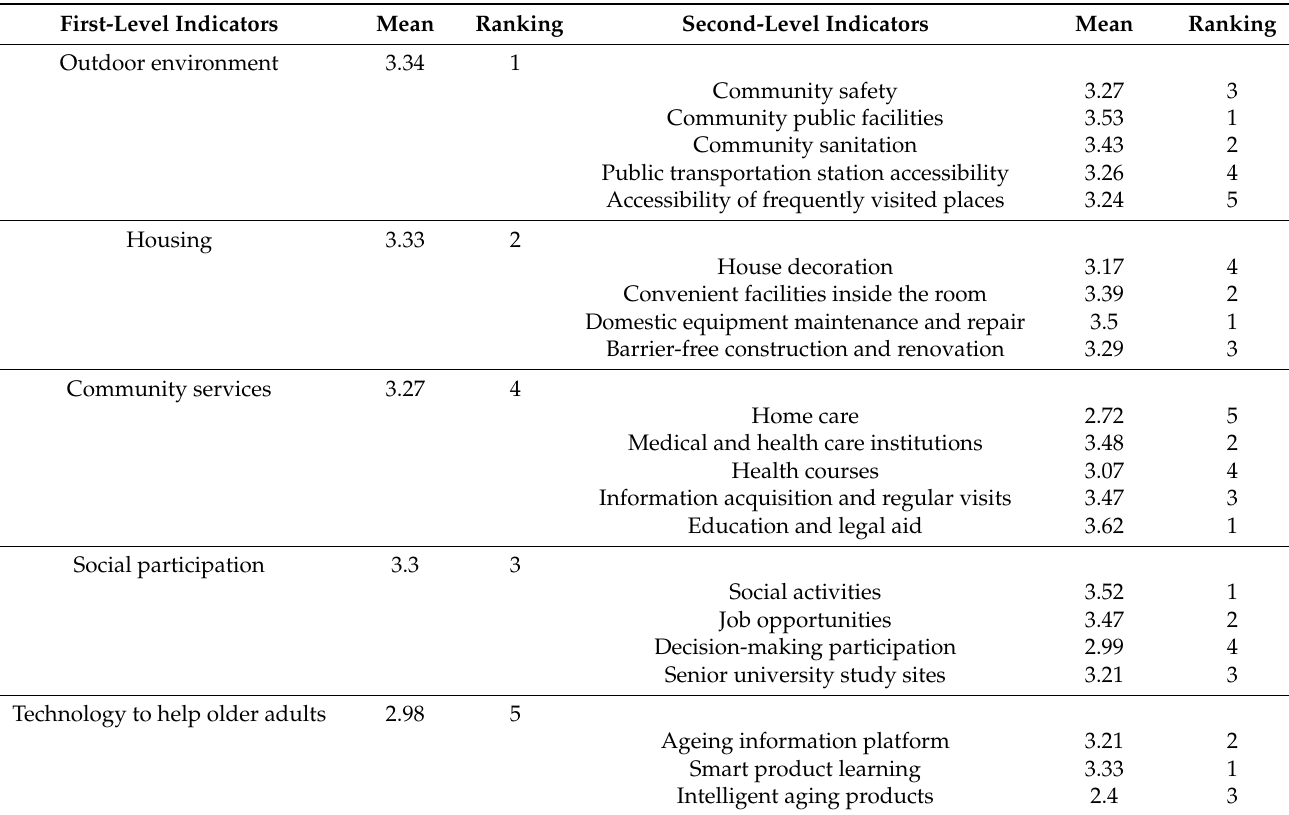
Table 5. Mean and rank of environmental demands in AFCs.